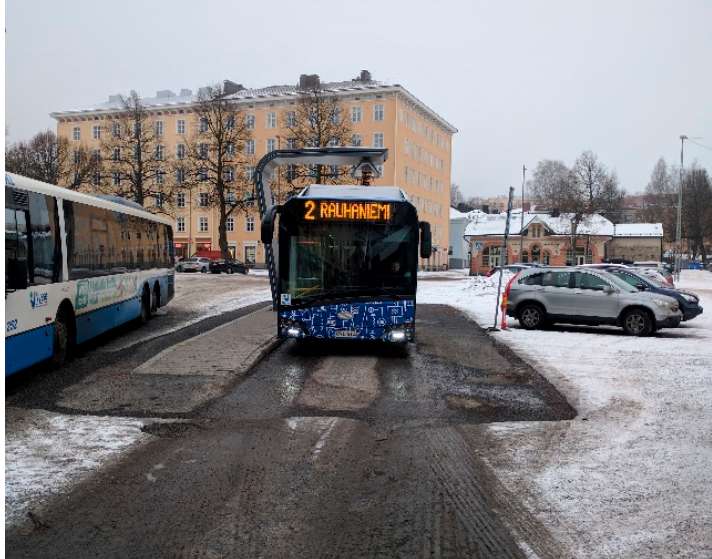
Figure 12. Heated foundation for the charging point to remove snow build-up on driving tracks.